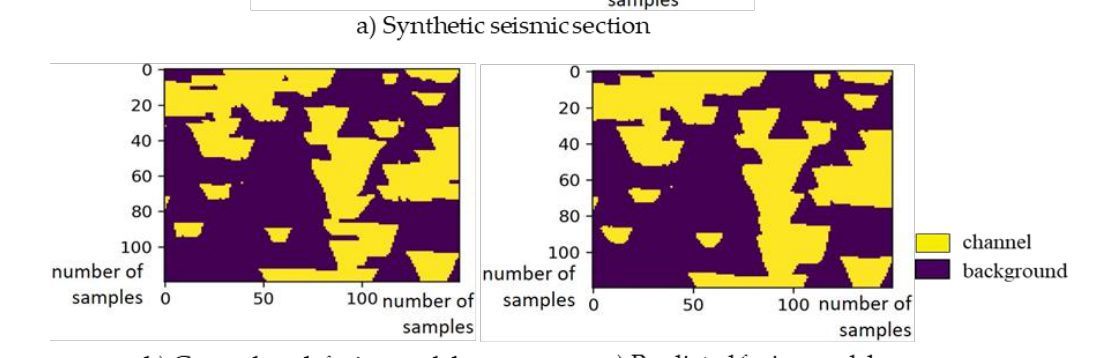
Figure 23. Synthetic seismic section ( a ), ground truth facies model ( b ) and predicted result ( c ). U-Net was trained on the entire training set. The prediction is very close to the true facies model.